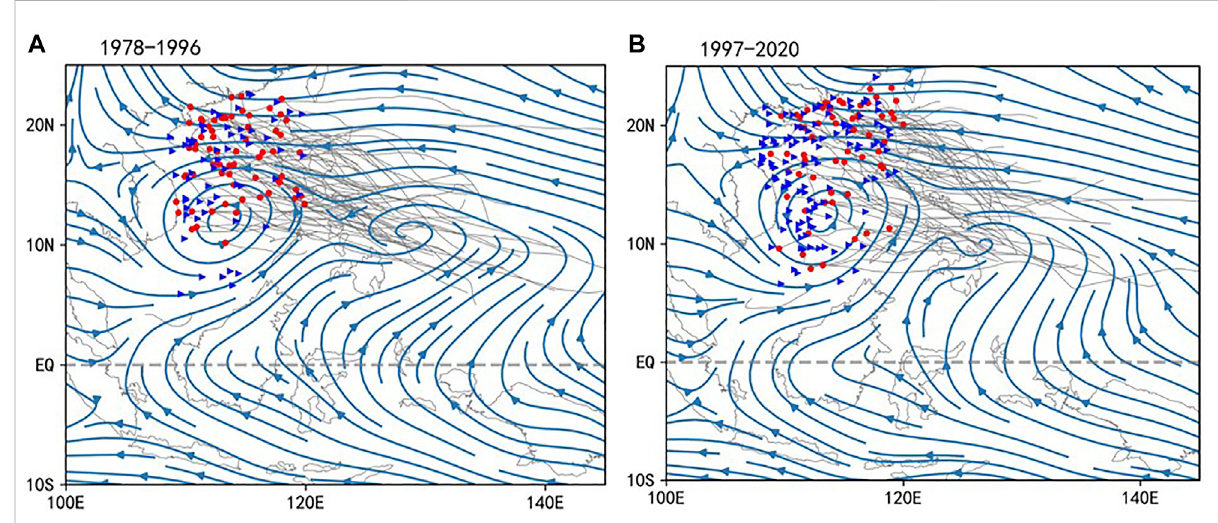
The streamline at 850-hPa and location of the LMI of local TCs (red dots) and migratory TCs (blue dots) for June – November during (A) 1978 – 1996 and (B) 1997 – 2020. The gray lines are TCs track from the genesis position to their LMI